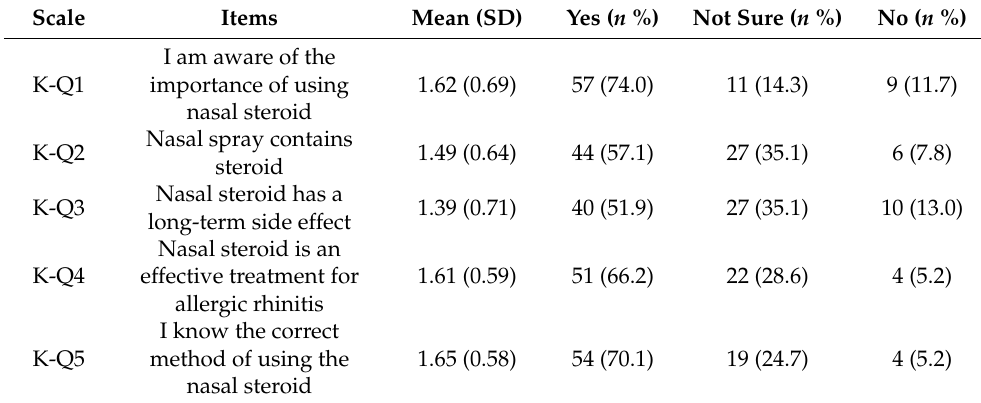
Table 3. Descriptive statistics of the items in the knowledge domain.